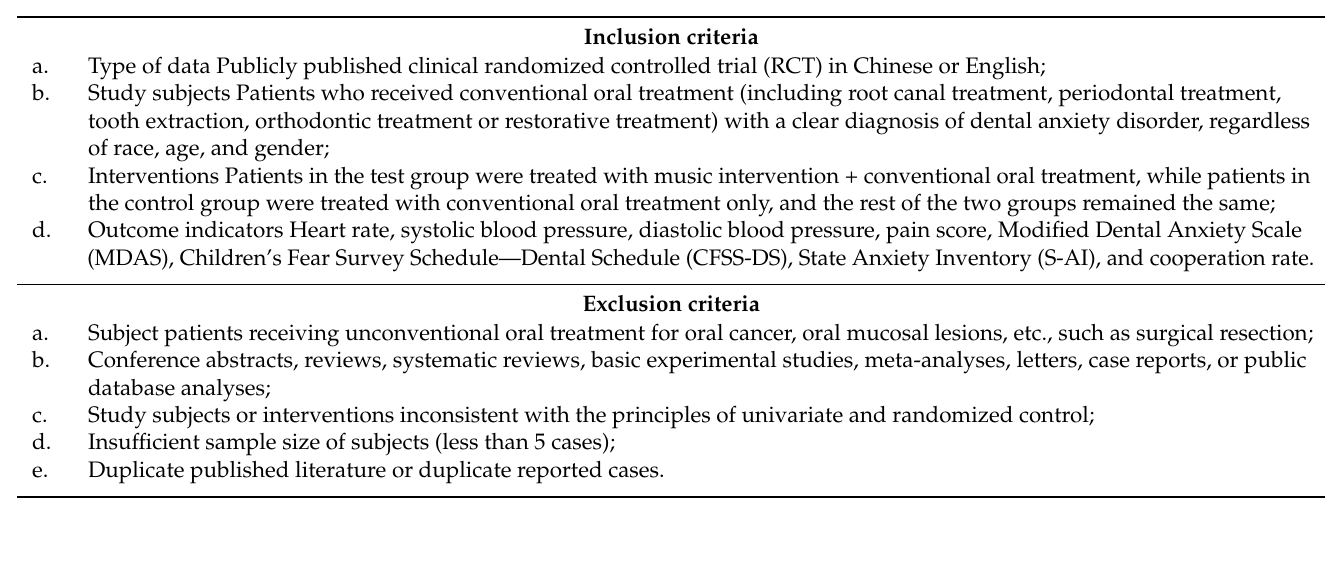
Table 1. Inclusion and exclusion